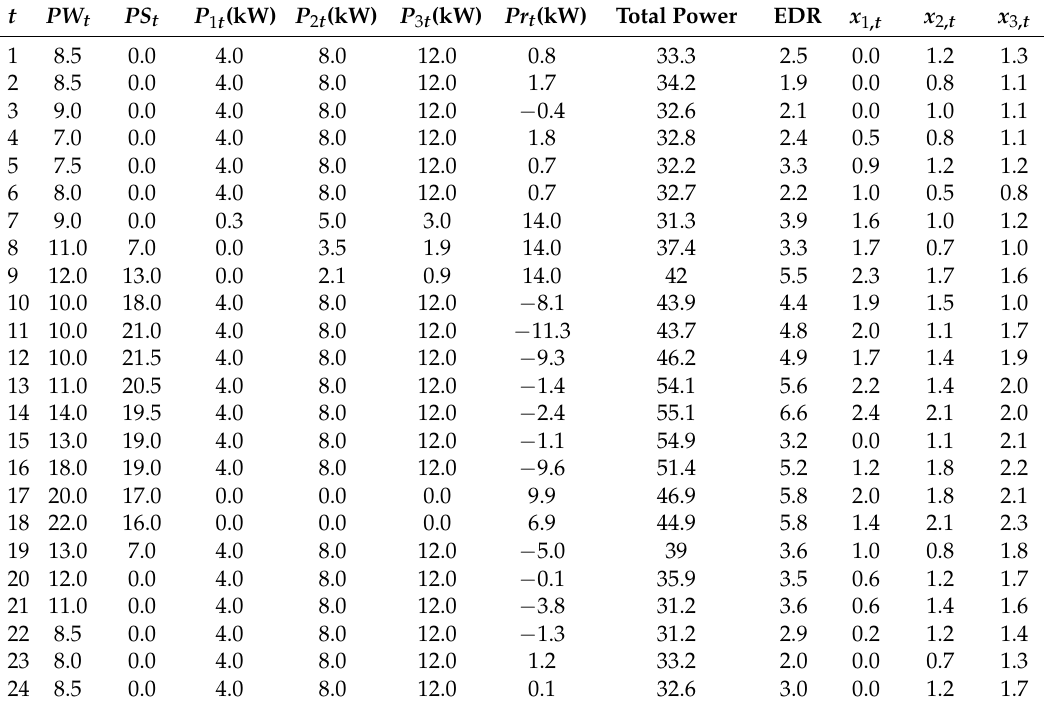
Table 4. kVA Energy dispatch of each distributed generator